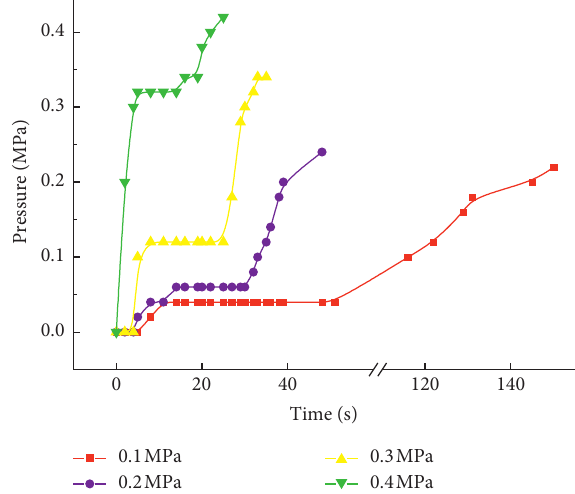
Figure 6: Pressure change in die during